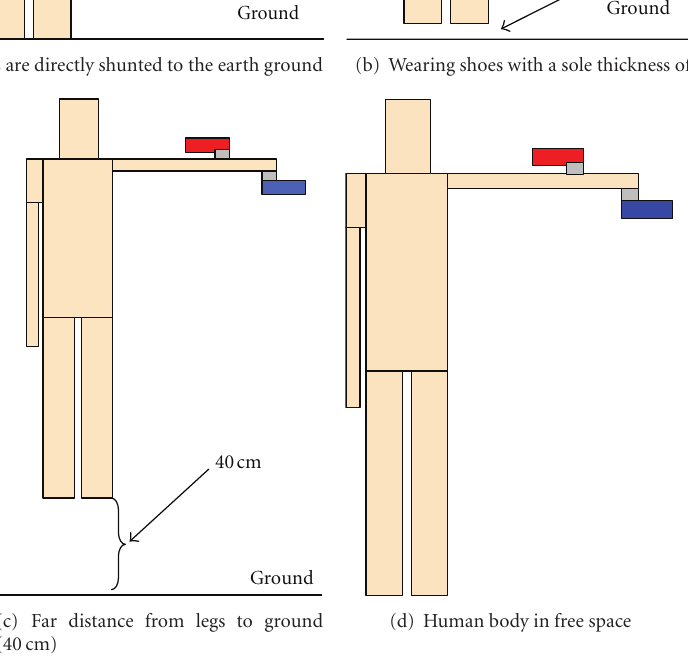
Figure 6: Verification models for the influence of the earth ground.